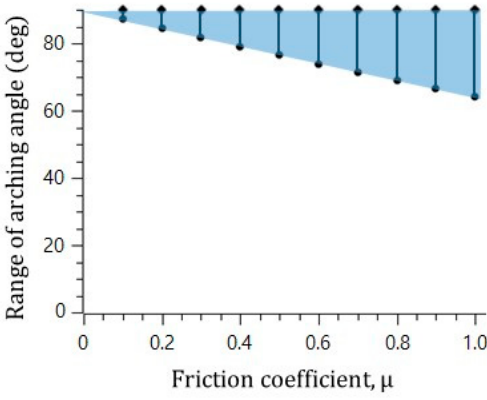
Figure 5. Decrease in the range of arching angle with decreasing friction force.